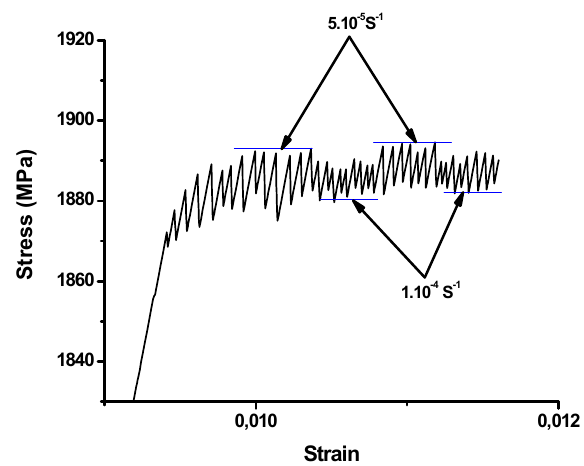
Figure 3. Simulated deformation curve of BMG alloy at oscillating strain rates of 5 × 10 − 5 s − 1 and 1 × 10 − 4 s − 1 (at room temperature) using the parameters of Table 1.